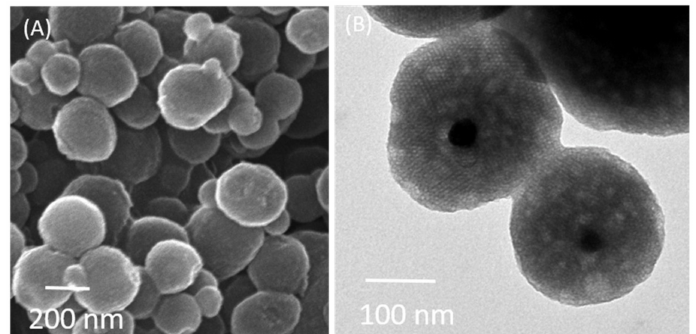
Figure 1. Microscopic images of magnetic mesoporous silica nanoparticles (Fe 3 O 4 @MSNs): ( A ) SEM image and ( B ) TEM images.